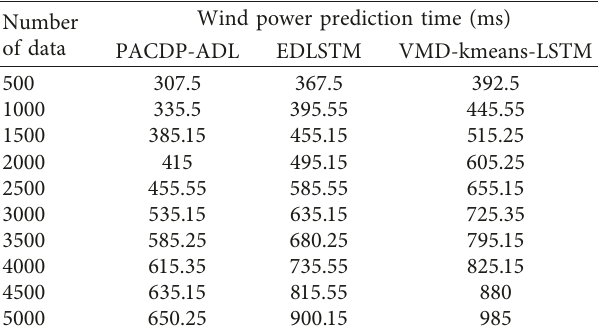
Table 3: True positive rate versus the number of data.